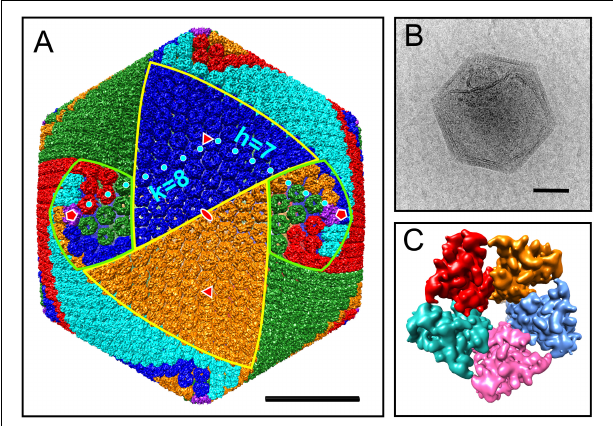
FIGURE 1 | Cryo-EM reconstruction of the AaV capsid. (A) Isosurface of AaV capsid. Capsomers are colored based on their orientation in red, blue, green, cyan, and orange. The pentameric capsomers are colored in purple. The borders of two trisymmetrons are highlighted in yellow, whereas the borders of two pentasymmetrons are highlighted in light green. The capsomer centers for calculating T number along h and k axes are labeled by cyan dots. Icosahedral fivefold, threefold, and twofold axes are labeled in red symbols. (B) Representative micrograph of an AaV particle. (C) Isosurface of the pentameric capsomer. The scale bars in panels (A,B) represent 500